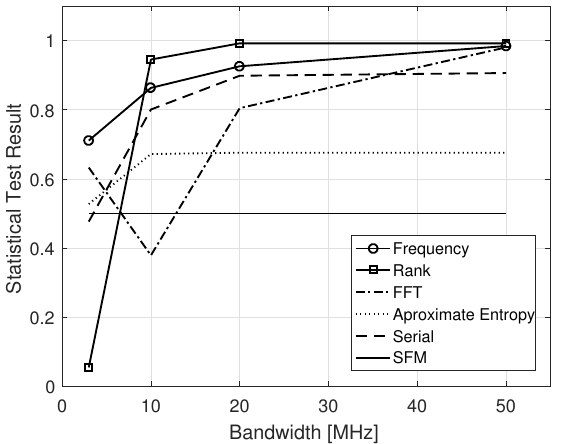
Figure 7. Statistical test results considering 4 pseudorandom narrowband frequency modulated signals (NBFM 3dB ) as a function of their 3 dB bandwidth—3 MHz, 10 MHz, 20 MHz, and 50